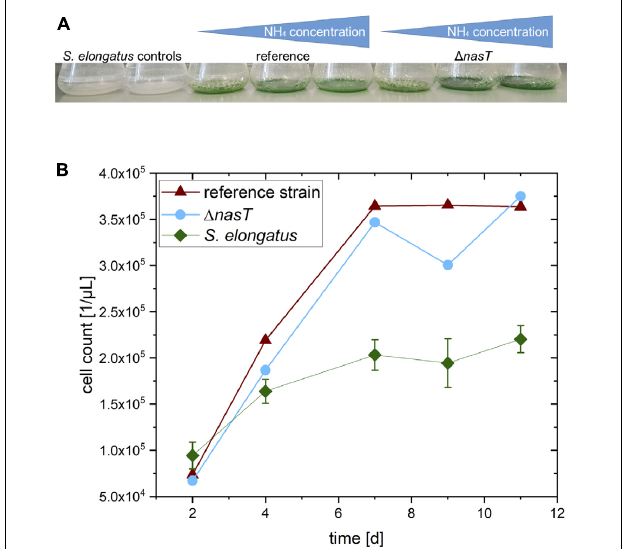
FIGURE 4 | Stabilizing effect of the co-cultivation. (A) Color of the cultures 4 weeks after the end of the experiment. Note that the mono-cultures have experienced complete chlorosis, whereas the co-cultures are still green. (B) Number of S. elongatus cscB cells in the different setups: S. elongatus , control: S. elongatus cscB in mono-culture; reference strain: Co-cultivation of S. elongatus cscB with P. putida cscRABY reference strain; (cid:49) nasT : Co-cultivation of S. elongatus cscB with P. putida (cid:49) nasT .